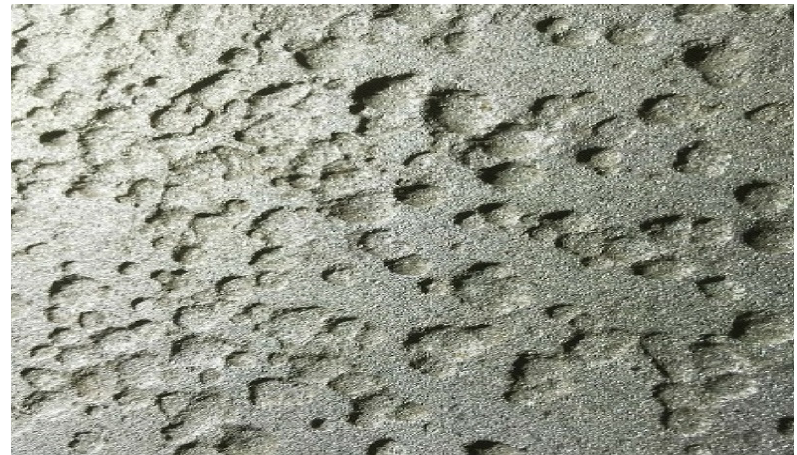
Figure 3. Example of Pitting Corrosion [12].